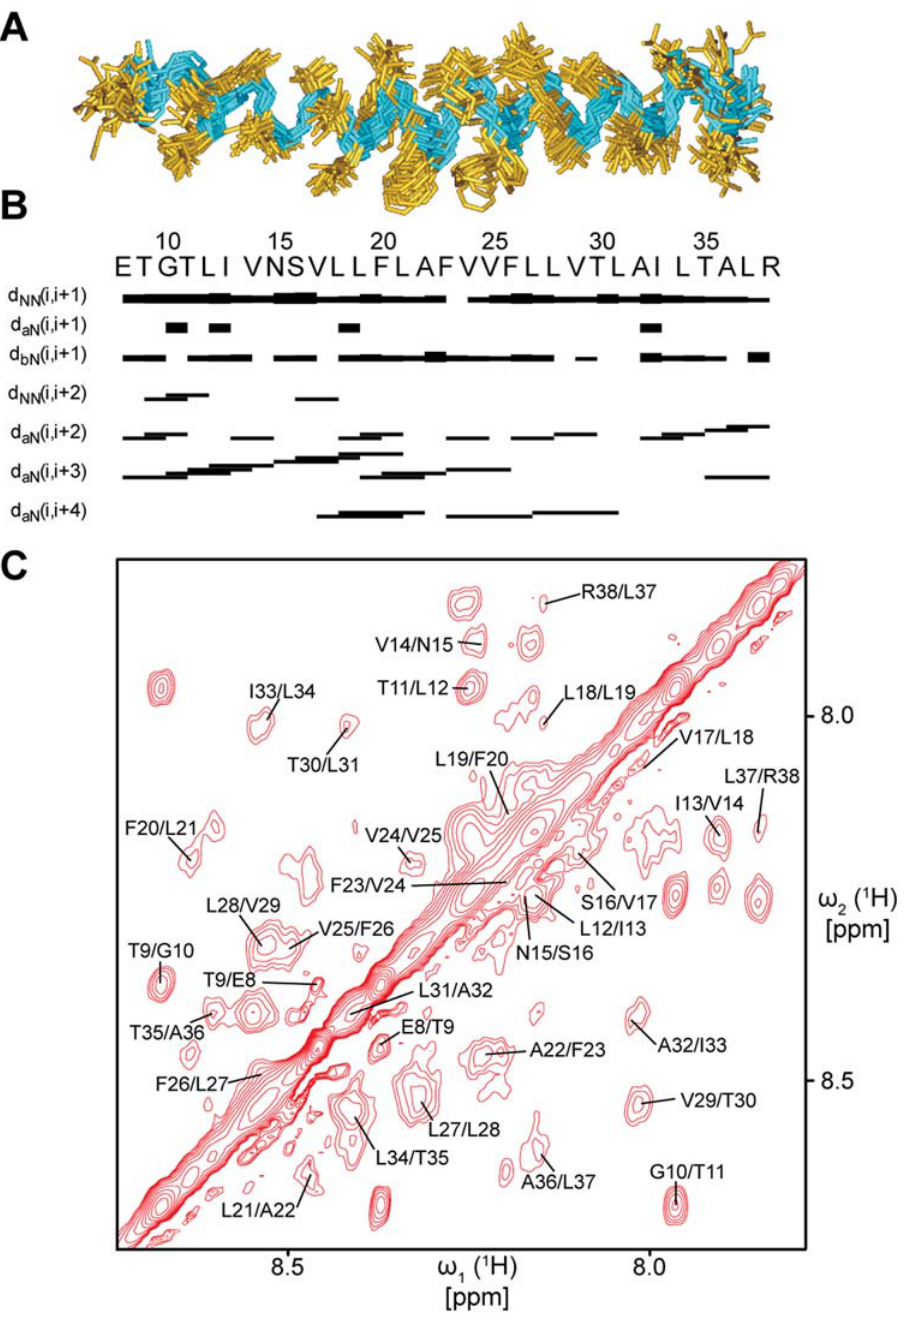
Figure 1. ETM forms a continuous a -helix in DPC micelles. (A) Superimposed 20 conformers of ETM (monomer) calculated from CYANA. The peptide backbone is shown in cyan and the residue side chains in gold. (B) Secondary structure plot for ETM depicted as bands of varying thickness, indicative of the NOE intensity. Sequential and medium range NOE connectivities are shown below the primary sequence. d NN amide backbones and d a N (i,i + 3), d a N (i,i + 4) connectivities are mostly continuous throughout the length of the peptide, indicating that the peptides adopt a predominantly a - helical conformation [71]. (C) Representative H N /H N region of 2D NOESY